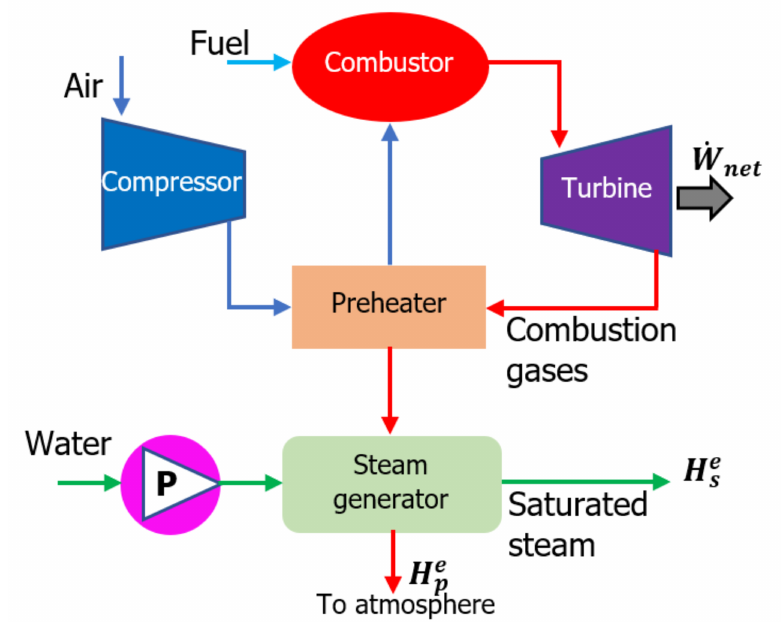
Figure 3. Schematic of a cogeneration